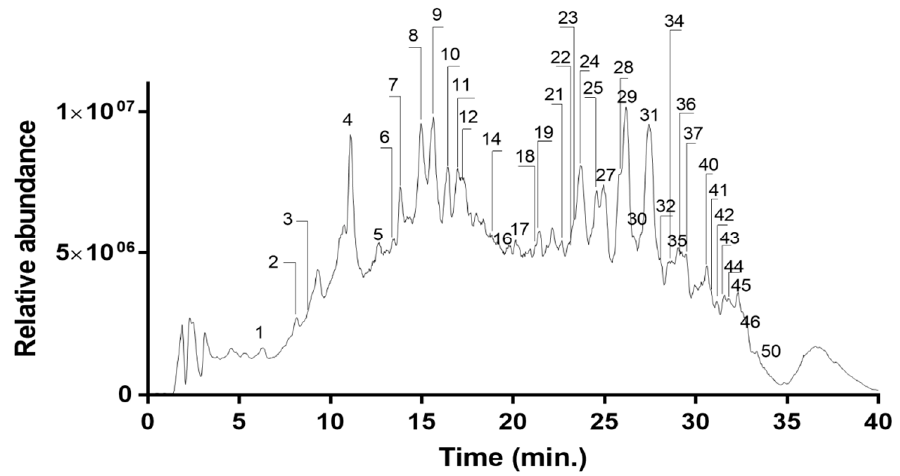
Figure 1. Total ion chromatogram of C. aegyptiaca methanolic extract in negative mode. Peak 1 (T R = 6.31 min, 2.32%) exhibited a molecular ion [M-H] − at m / z 341, and its MS 2